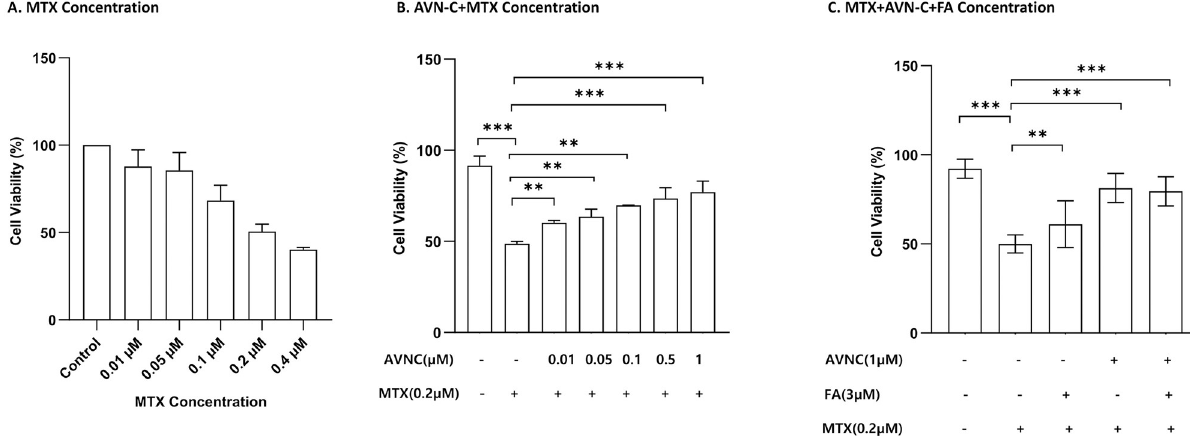
Fig 6. MTX and AVN-C cell viability is dose-dependent. Effect of MTX on the viability of HEI-OC1 cells. Panel A: Cell viability was significantly reduced at concentrations of MTX � 0.2 μ M. MTX reduced the cell viability in a concentration-dependent manner. Panel B: Pre-treatment of HEI-OC1 cells with various concentrations of AVN-C for 3 hours before addition of 0.2 μ M of MTX for 24 hours provided the best protection. Panel C: HEI-OC1 cells were pretreated for 3 hours with 1 μ M of AVN-C and 3 μ M of FA simultaneously before being exposed to 0.2 μ M of MTX for 24 hours. AVN-C alone or AVN-C concomitant to FA showed a significant protective effect against MTX cytotoxicity ( ��� p < 0.001), while FA showed moderate effect. �� p < 0.01; one-way ANOVA. Each group was tested seven times.